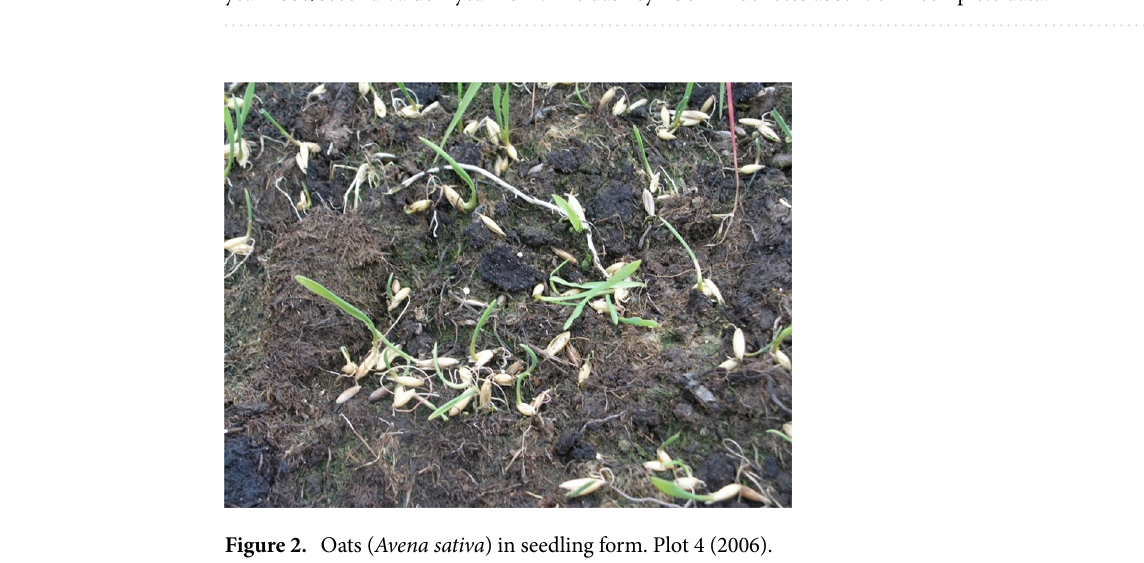
Table 3. Biodiversity indicators for experimental, control, and background territories. First value in the cells— year 2006/second value—year 2014. The dash symbol “-” denotes absent or incomplete data.